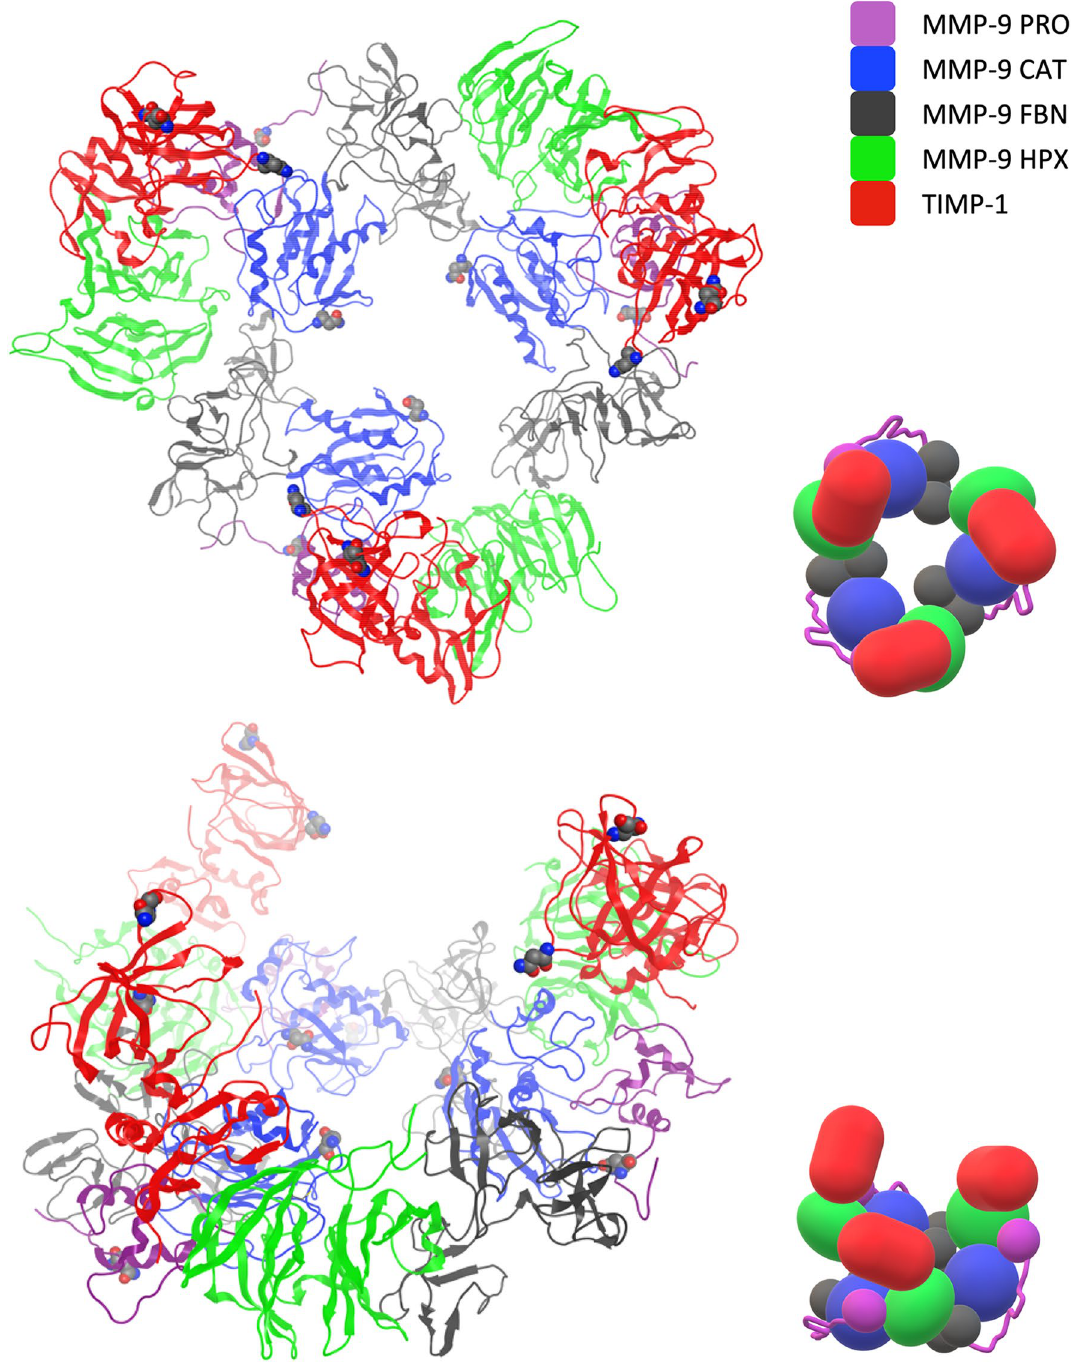
Figure 2. Structural model of the circular proMMP-9 heterohexamer with TIMP-1. On the left – a ribbon presentation of the structure; on the right – a schematic representation indicating existing domains and their mutual arrangement. The hemopexin domain (green) interacts with the catalytic (blue) domain, propeptide (purple) of one subunit, and with the fibronectin (grey) domain of the other one. TIMP-1 is attached to the complex in a direction that does not change the diameter of the complex. Amino acids undergoing N-glycosylation are shown as Van der Waals spheres. The bottom images are rotated 60 degrees about the horizontal axis, in relation to the upper